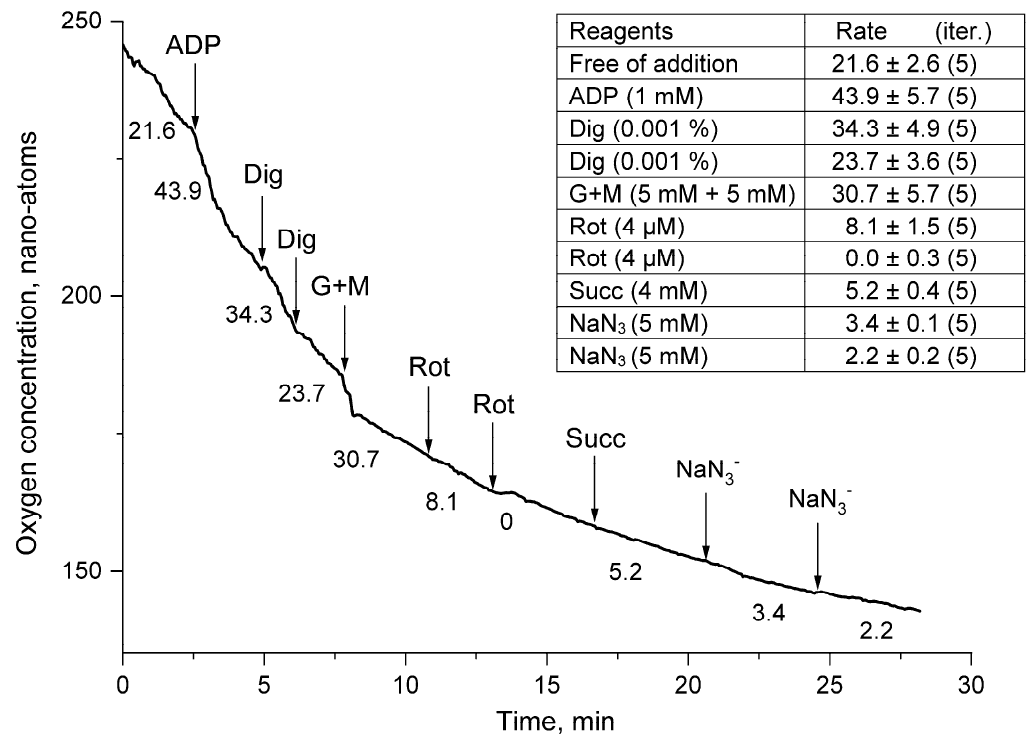
Figure 5. Rates of oxygen uptake by a suspension of thornback ray erythrocytes permeabilized with digitonin in the presence of ADP (1 mM). The medium, additives, and designations are the same as in Figure 4.